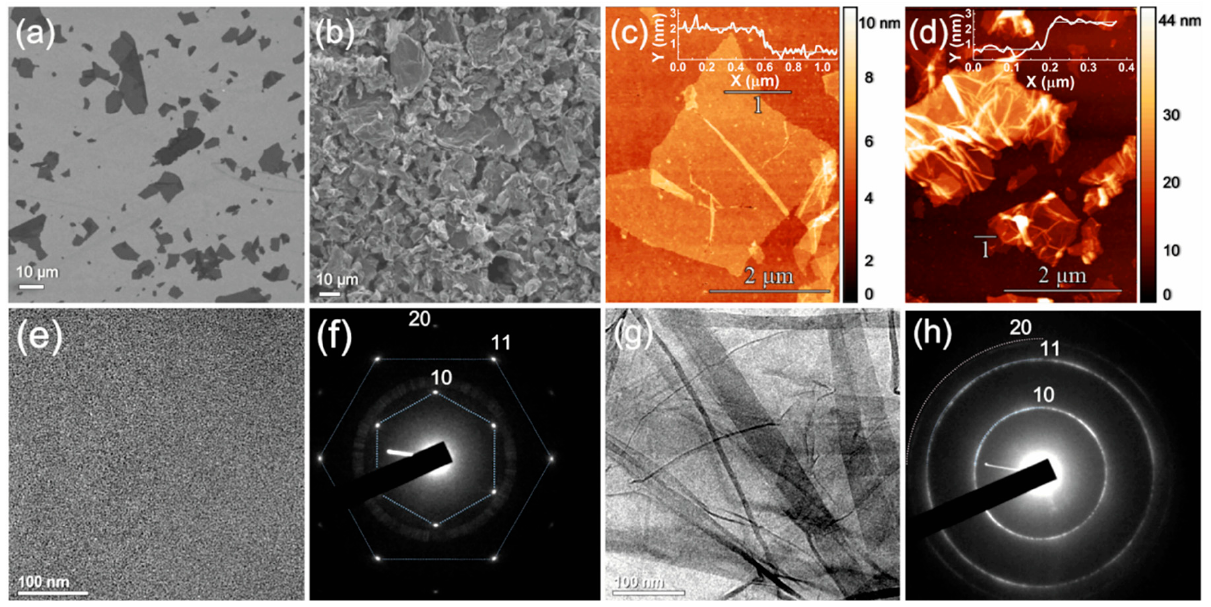
Figure 3. Microscopic studies of the morphology of the initial GO and rGO–Th. ( a , b ) SEM and ( c , d ) AFM images of the platelets of GO and rGO–Th, respectively. Insert—height profile measured along the line 1. ( e , g ) TEM images and ( f , h ) ED patterns of GO and rGO–Th, respectively.